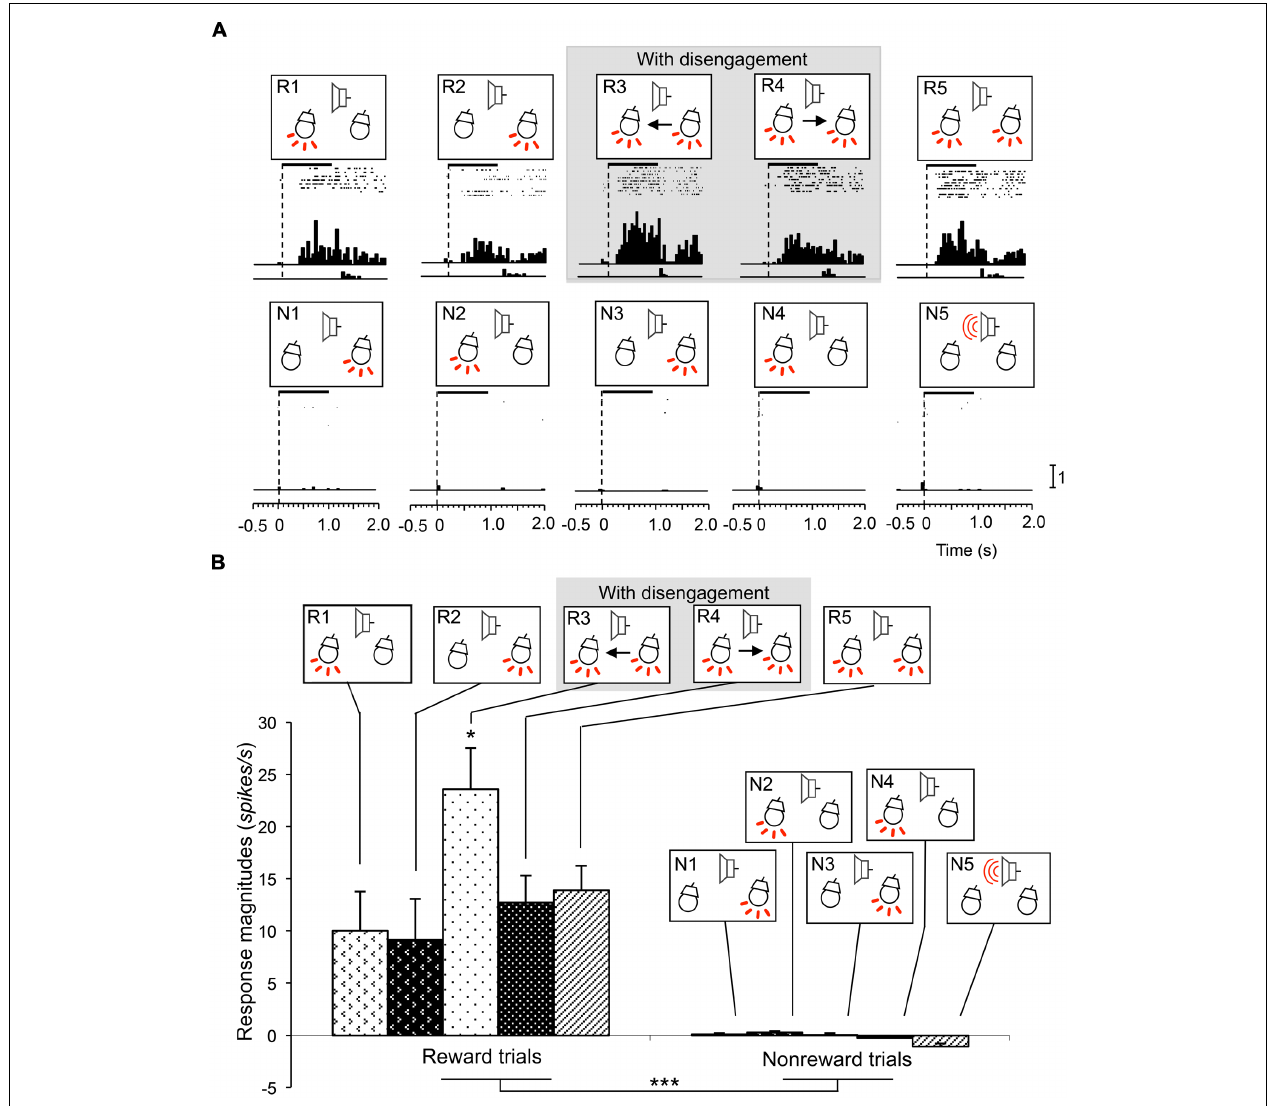
displays and histograms indicates stimulus onset. Calibration at the right bottom of the figure indicates the number of spikes per trial in each bin. Bin width, 50 ms. (B) Comparison of response magnitudes of the neuron shown in A to the CSs. This neuron responded stronger to the CSs in session 3 (R3). *significant difference from the CSs in R1, R2, R4, and R5 (Tukey test, P < 0.05); ***significant difference from the CSs in N1–N5 (Tukey test, P <